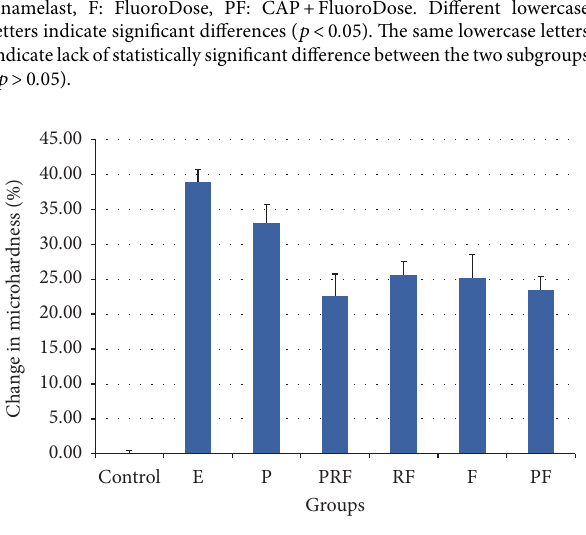
Figure 2: Mean and 95% confidence interval of the change in microhardness in different groups: E, Erosion, P CAP, PRF: CAP+Enamelast, RF: Enamelast, F FluoroDose, PF: CAP+FluoroDose.